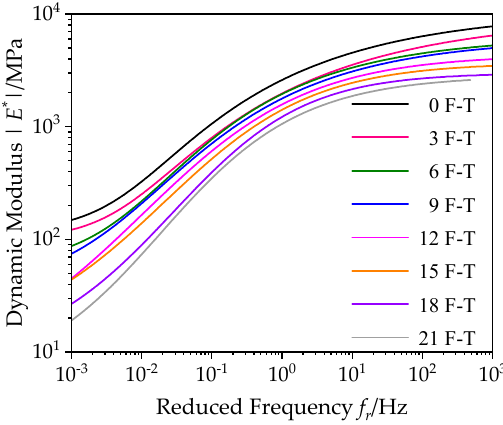
Figure 8. Comparison of dynamic modulus master curves under F–T cycles (20 °C).